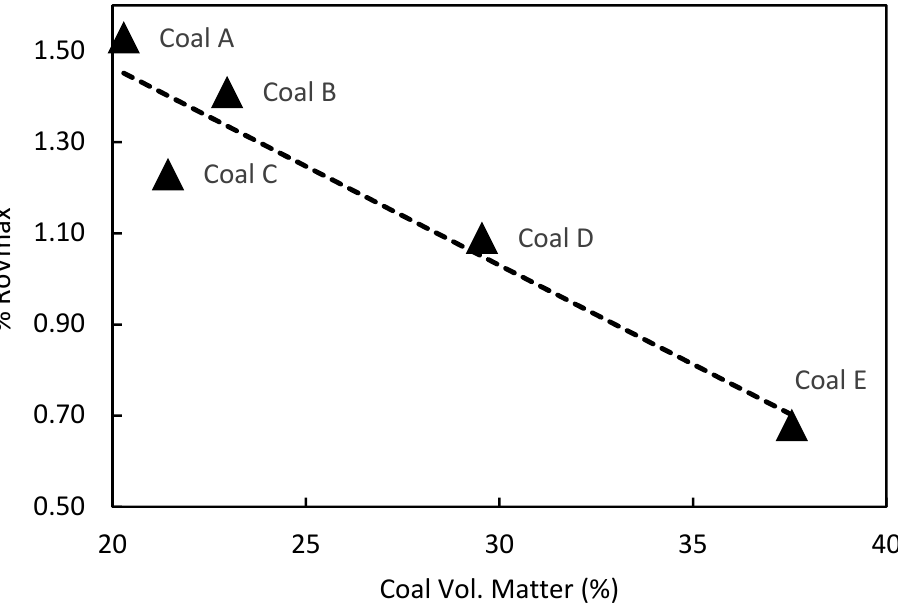
Figure 1. Parent coal rank, expressed as %RoVmax, as a function of volatile matter. The pilot coke oven has comparable width dimensions to a typical industrial coke oven and is believed to produce coke that is comparable in properties to that produced by industrial coke ovens [6]. Using pilot coke ovens in research has the added advantage that they can produce relatively small amounts of coke from single sources without the risk of damage to the integrity of the coke oven structure. The 400 kg coal sample for each coal source collected was reduced in particle size to about 80% (3.35 mm) using a hammer mill as per the requirement when producing industrial coke with the top charging method. The oven temperature control set points were kept similar for the five coals under study. Table 3 gives the coking conditions achieved for each coal during the coking